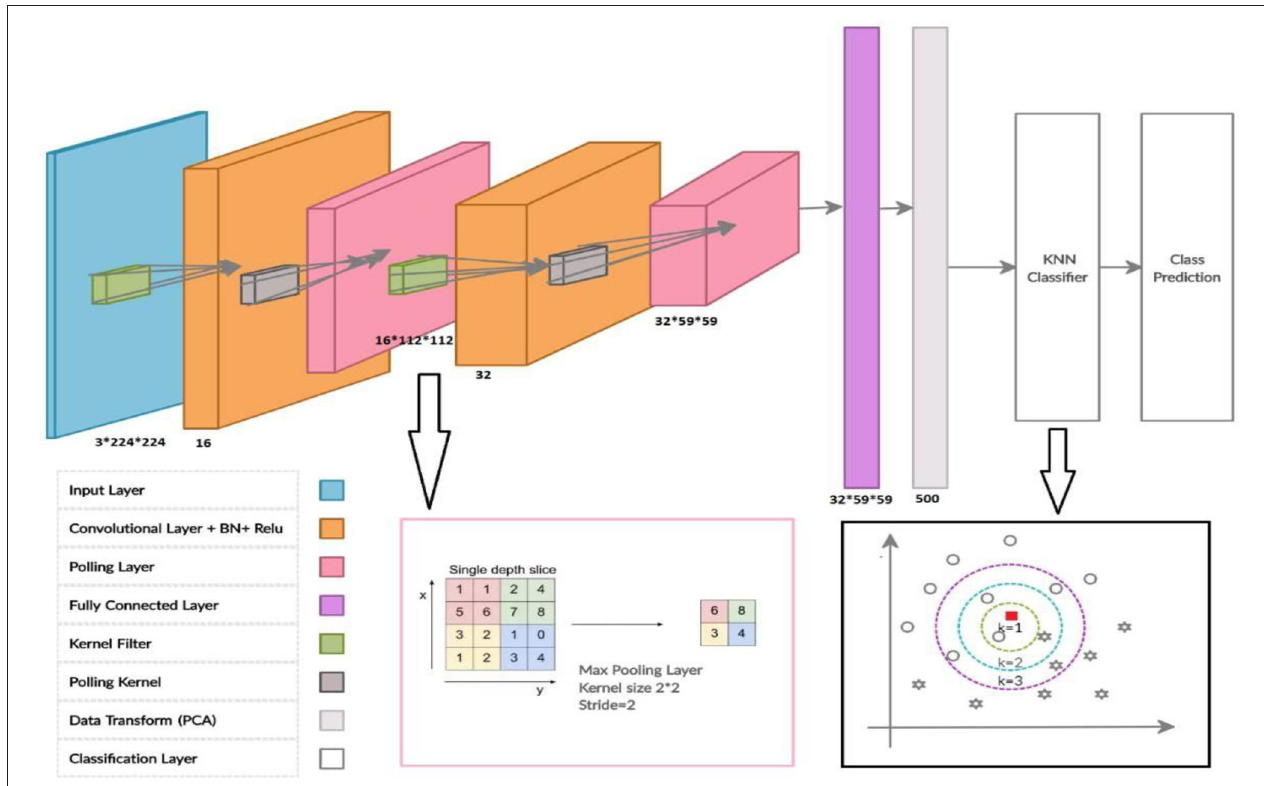
FIGURE 1 | The architecture of the proposed HCNN-KNN